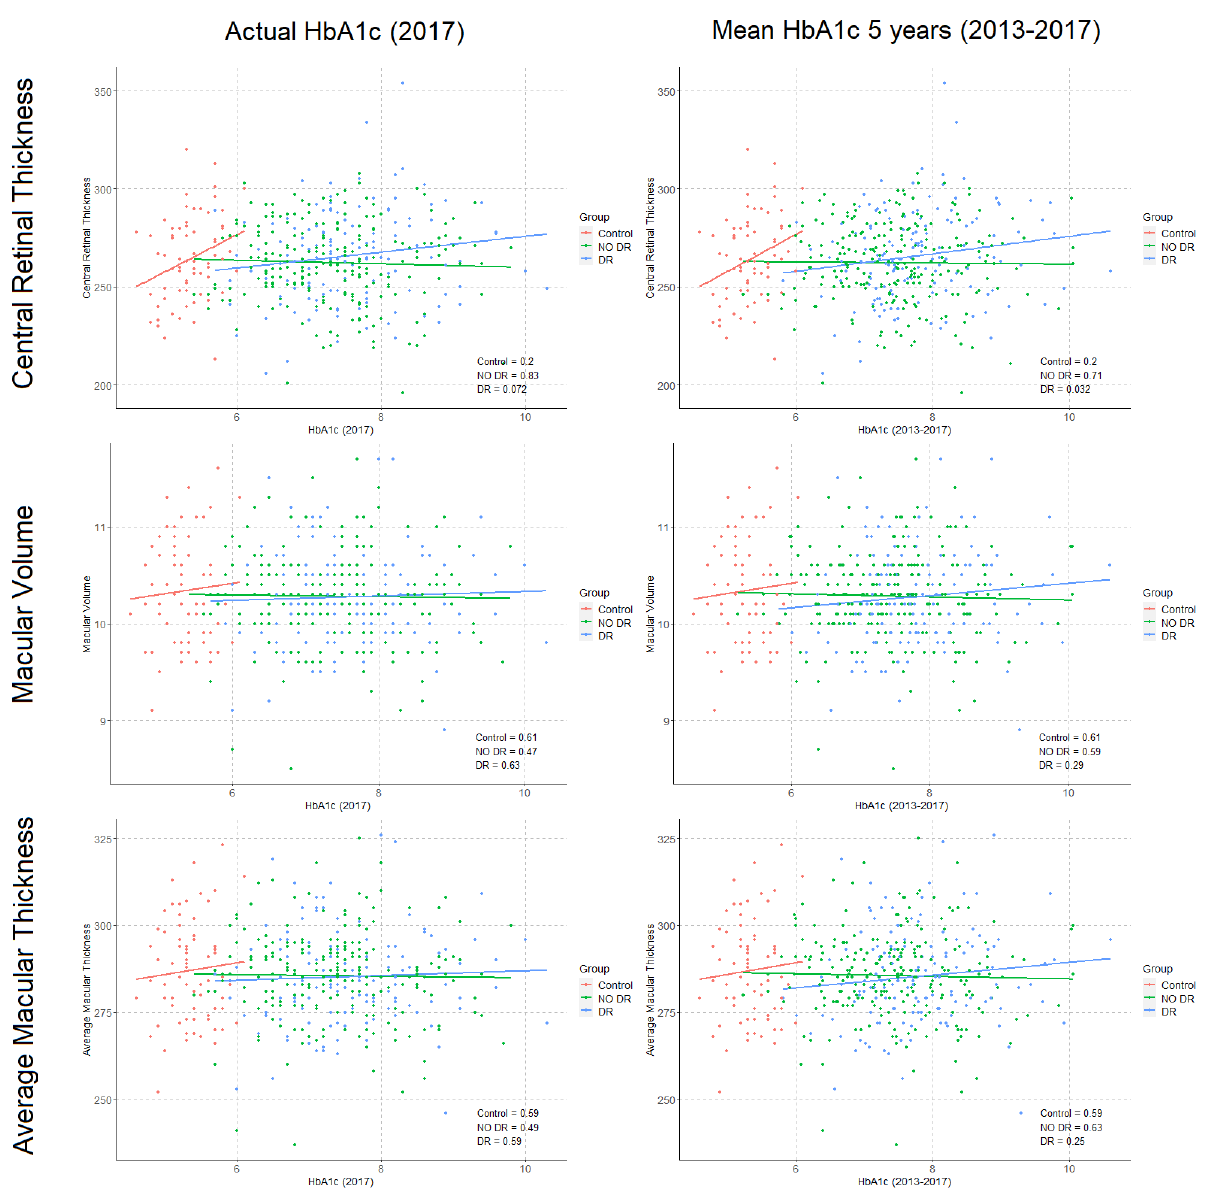
Figure 4. Correlations between glycated haemoglobin (HbA1c) levels and structural optical coherence tomography (OCT) parameters in study subgroups. Left : Structural OCT parameters and actual HbA1c level at the retinal imaging timepoint (2017). Right : Structural OCT parameters and Mean HbA1c calculated from previous 5 years timepoints (2013 to 2017). (Numerical values represent the p -value of correlations, p -values are adjusted by age, sex, signal strength index, diabetes mellitus duration, and axial length).